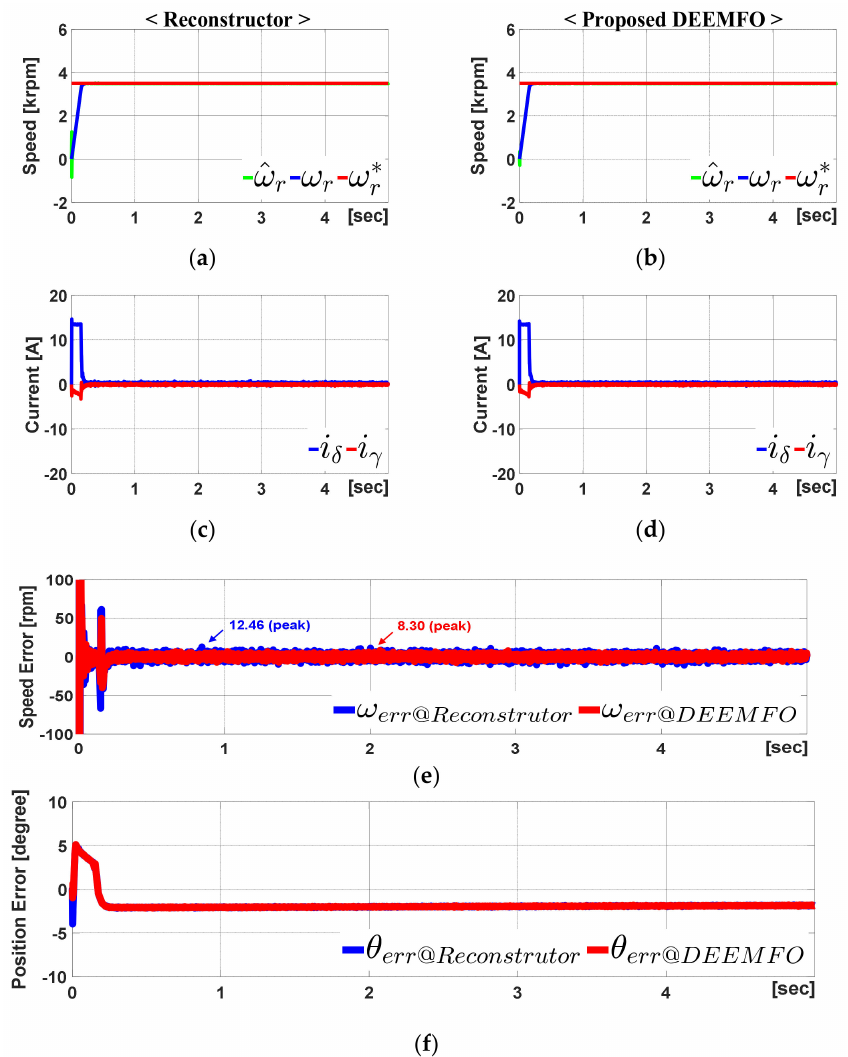
Figure 7. Simulation results under no load condition. ( a ) reference, real, and estimated speed with reconstructor; ( b ) reference, real, and estimated speed with DEEMFO; ( c ) γ − δ axis currents with reconstructor; ( d ) γ − δ axis currents with DEEMFO; ( e ) comparison of speed errors in reconstructor and DEEMFO; ( f ) comparison of position errors in reconstructor and